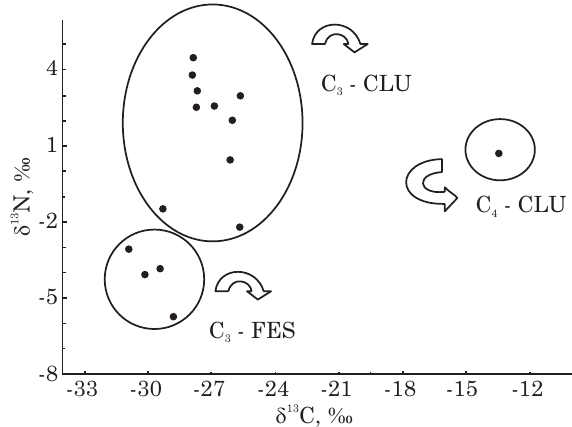
Figura 2. Valores de δδδδδ 13 C e δδδδδ 15 N nas espécies vegetais predominantes das fitofisionomias Campo Limpo Úmido (CLU) e Floresta Estacional Semidecidual